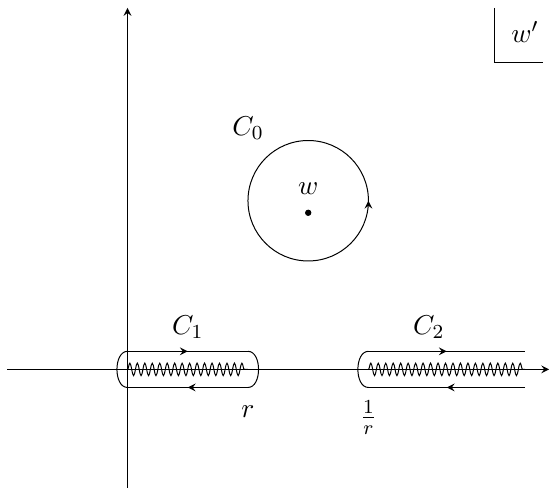
Figure 1 . Summary of integration contours in the complex w 0